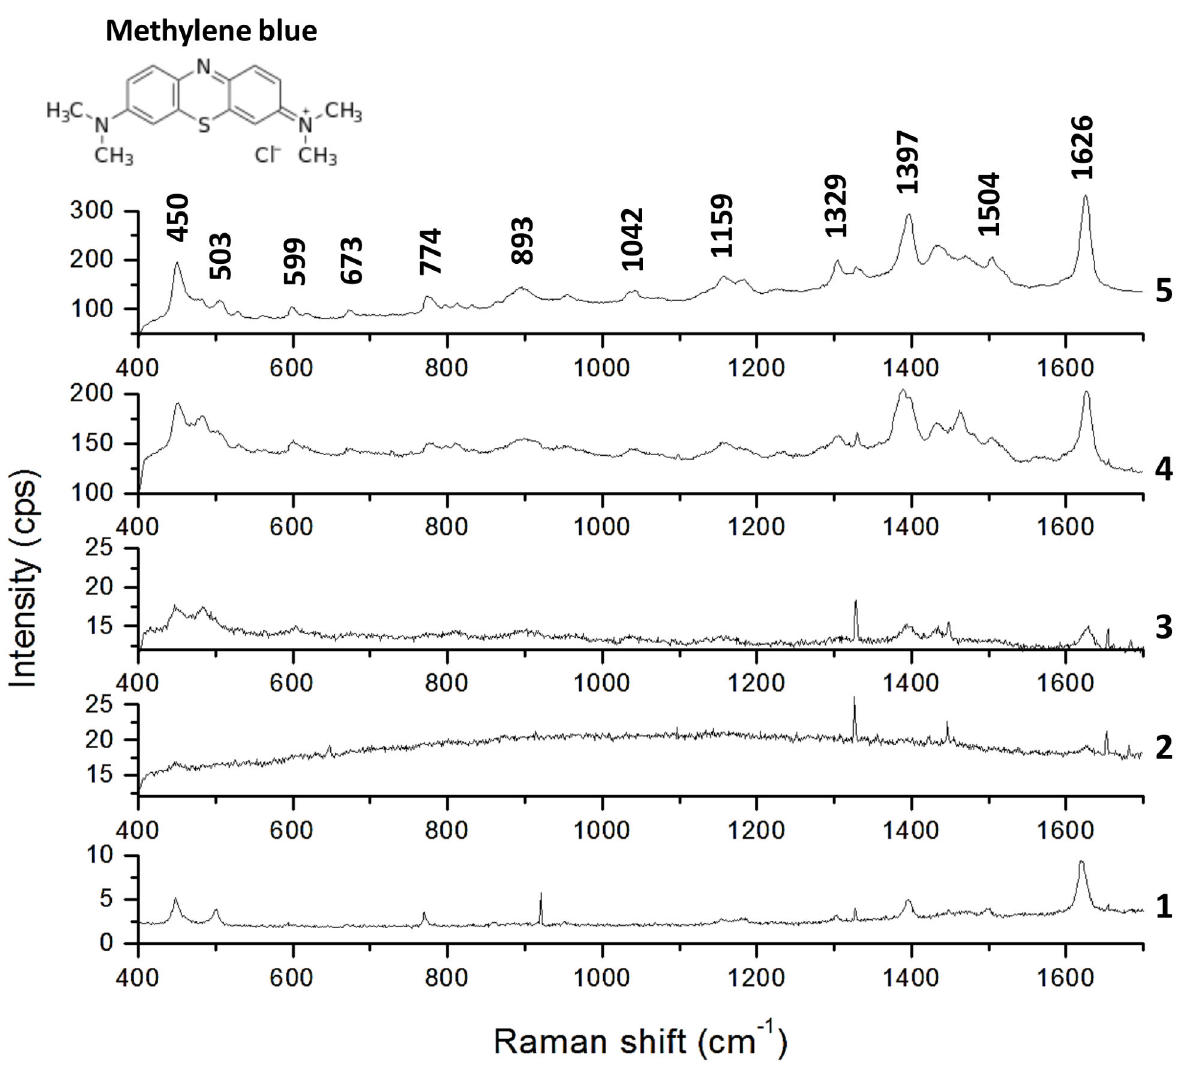
Figure 3. SERS. Raman spectra of MB (1), MB + fungal extract (2), MB + quasi-spherical AuNPs of 3 to 12 nm (3), MB + quasi- spherical AuNPs with some different shapes of 6 to 23 nm (4), and MB + different shaped gold nanoparticles with a broad size range